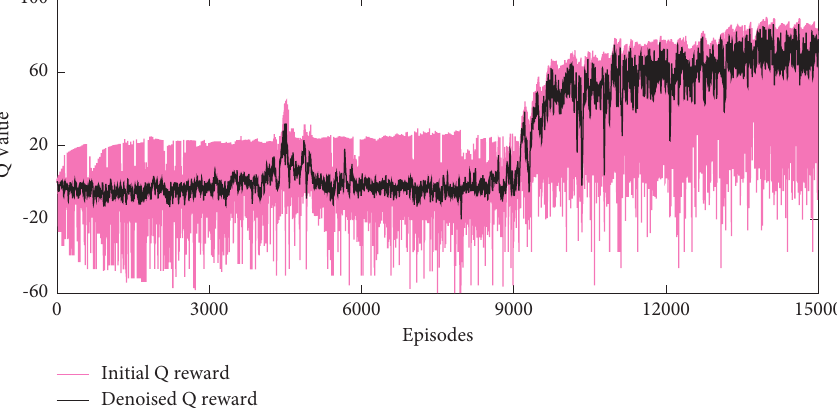
Figure 8: Multiagent Q value update process.